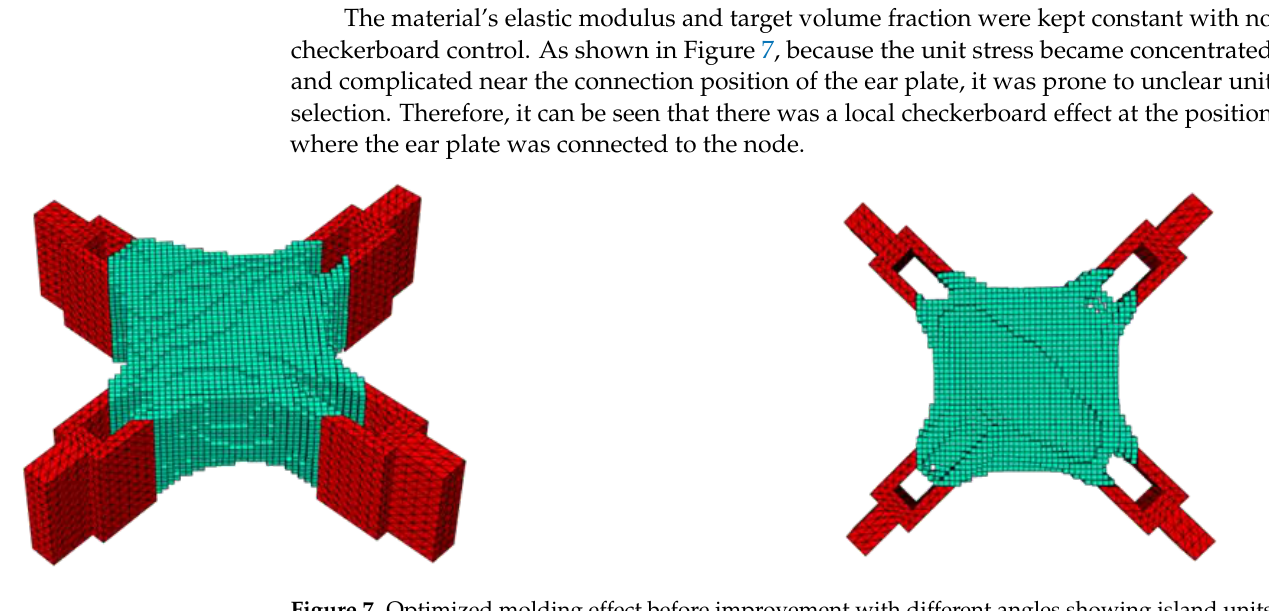
Figure 7. Optimized molding effect before improvement with different angles showing island units (the red part is the load application area, and the green part is the design domain).